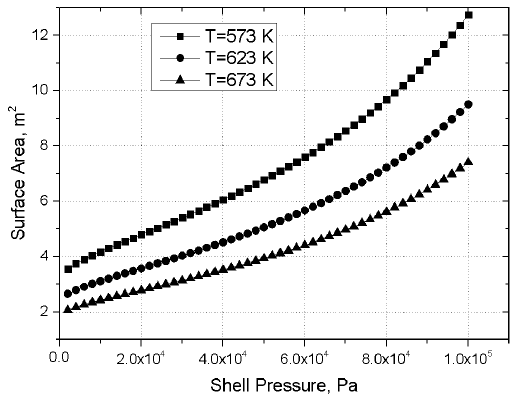
Figure 5. Membrane area required vs. the shell (permeate) pressure at different temperatures and 1 MPa of lumen pressure.